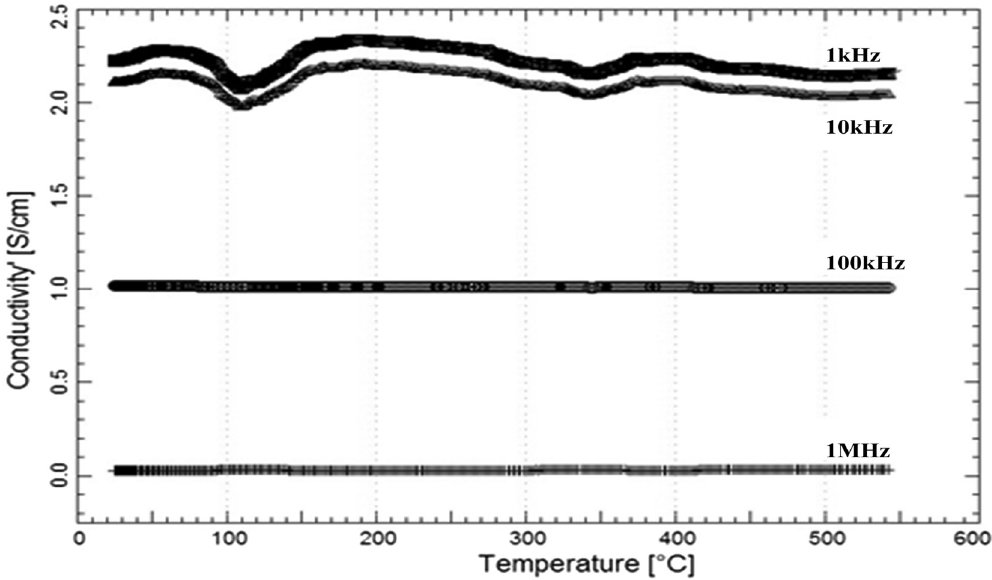
Figure 8: AEPA graphs of the composition - dependent change in conductivity - received 25% Ni - coated Fe – Co